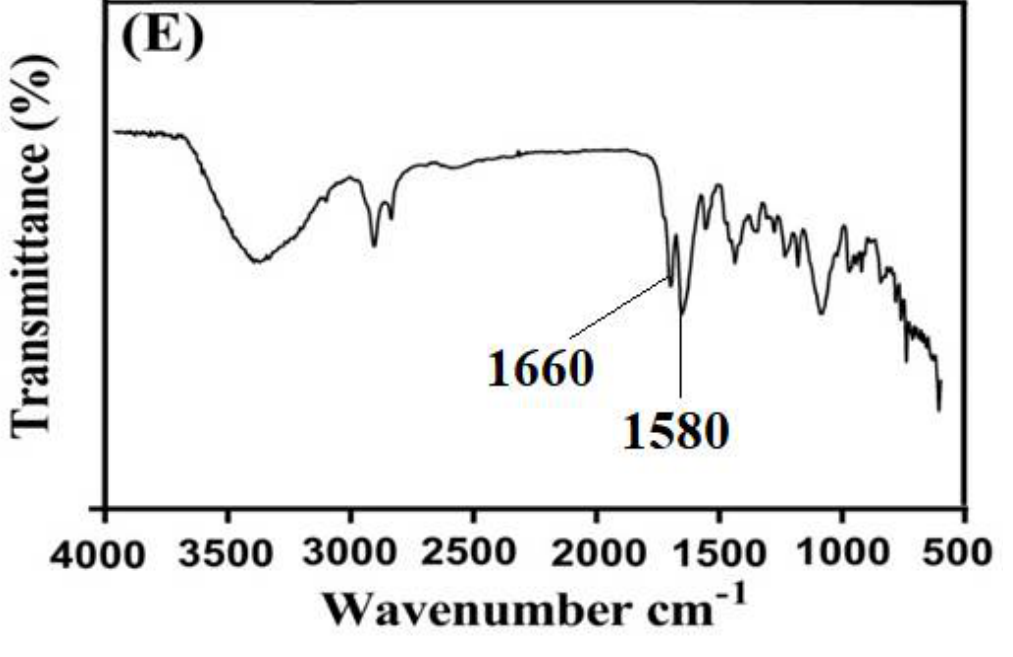
Figure 7. FTIR spectra of ( A ) ASPA, ( B ) AMPS, ( C ) unloaded ASPA-pAMPS microgels (AFn-3), ( D ) TP, and ( E ) loaded ASPA-pAMPS microgels (AFn-3).